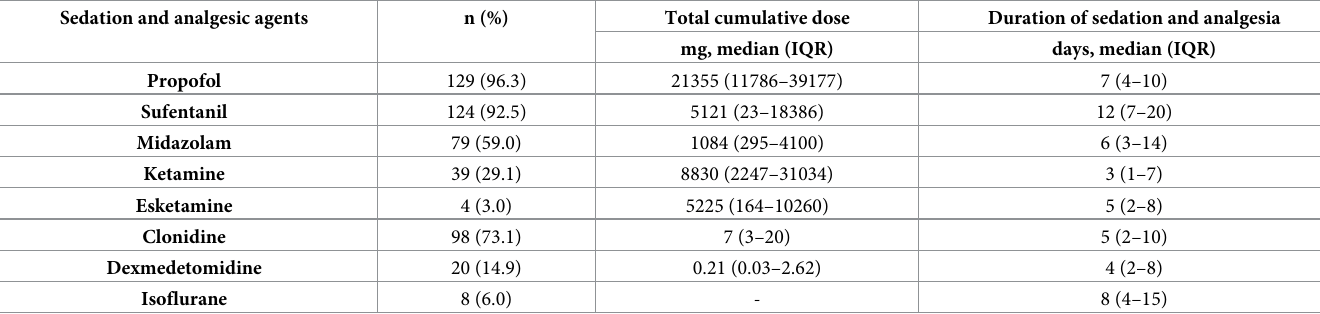
Table 2. Total cumulative dose and duration of sedation and analgesia in ARDS survivors (N = 134). Sedation and analgesic agents n (%) Total cumulative dose Duration of sedation and analgesia mg, median (IQR) days, median (IQR) Propofol 129 (96.3) 21355 (11786–39177) 7 (4–10) Sufentanil 124 (92.5) 5121 (23–18386) 12 (7–20) Midazolam 79 (59.0) 1084 (295–4100) 6 (3–14) Ketamine 39 (29.1) 8830 (2247–31034) 3 (1–7) Esketamine 4 (3.0) 5225 (164–10260) Clonidine 98 (73.1) 7 (3–20) 5 (2–10) Dexmedetomidine 20 (14.9) 0.21 (0.03–2.62) 4 (2–8) Isoflurane 8